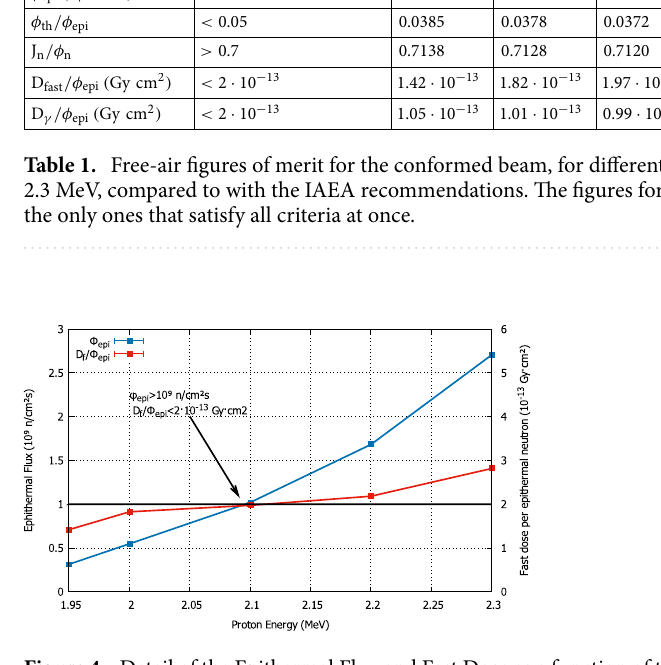
Figure 4. Detail of the Epithermal Flux and Fast Dose as a function of the proton energy incident on the 7 Li target, compared with the IAEA recommendation figures. The value of 2.1 MeV is marked as both the epithermal flux and the fast dose are attained above and below their criterion, respectively.